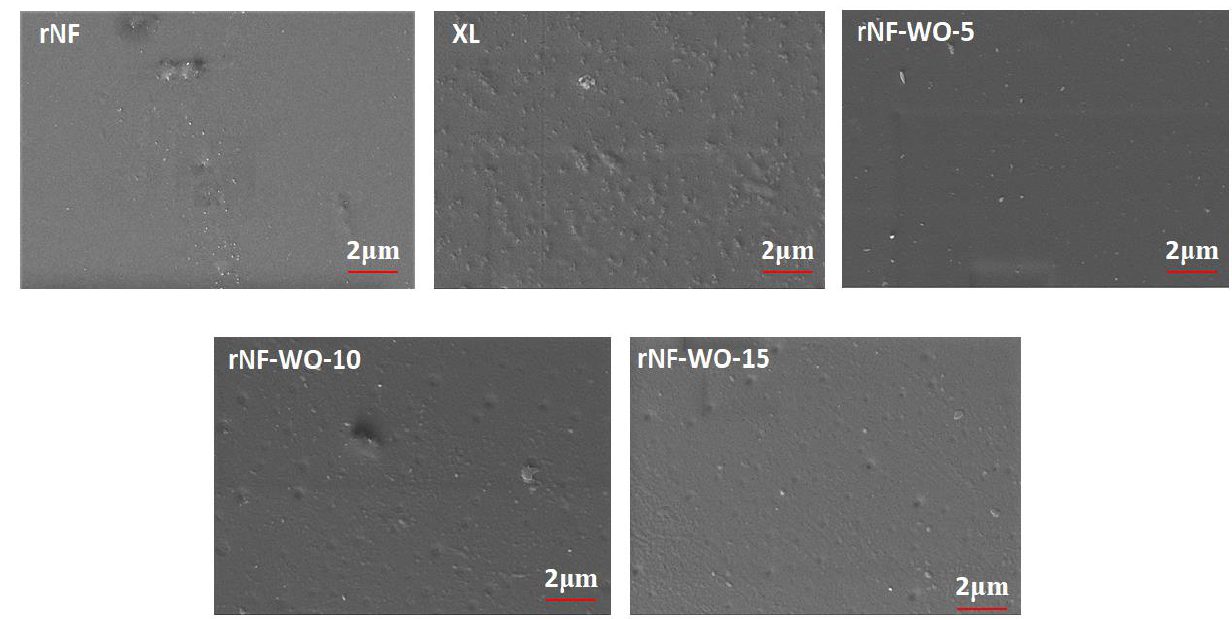
Figure 3. Surface morphology of the hybrid membranes with 5, 10, and 15% WO 3.